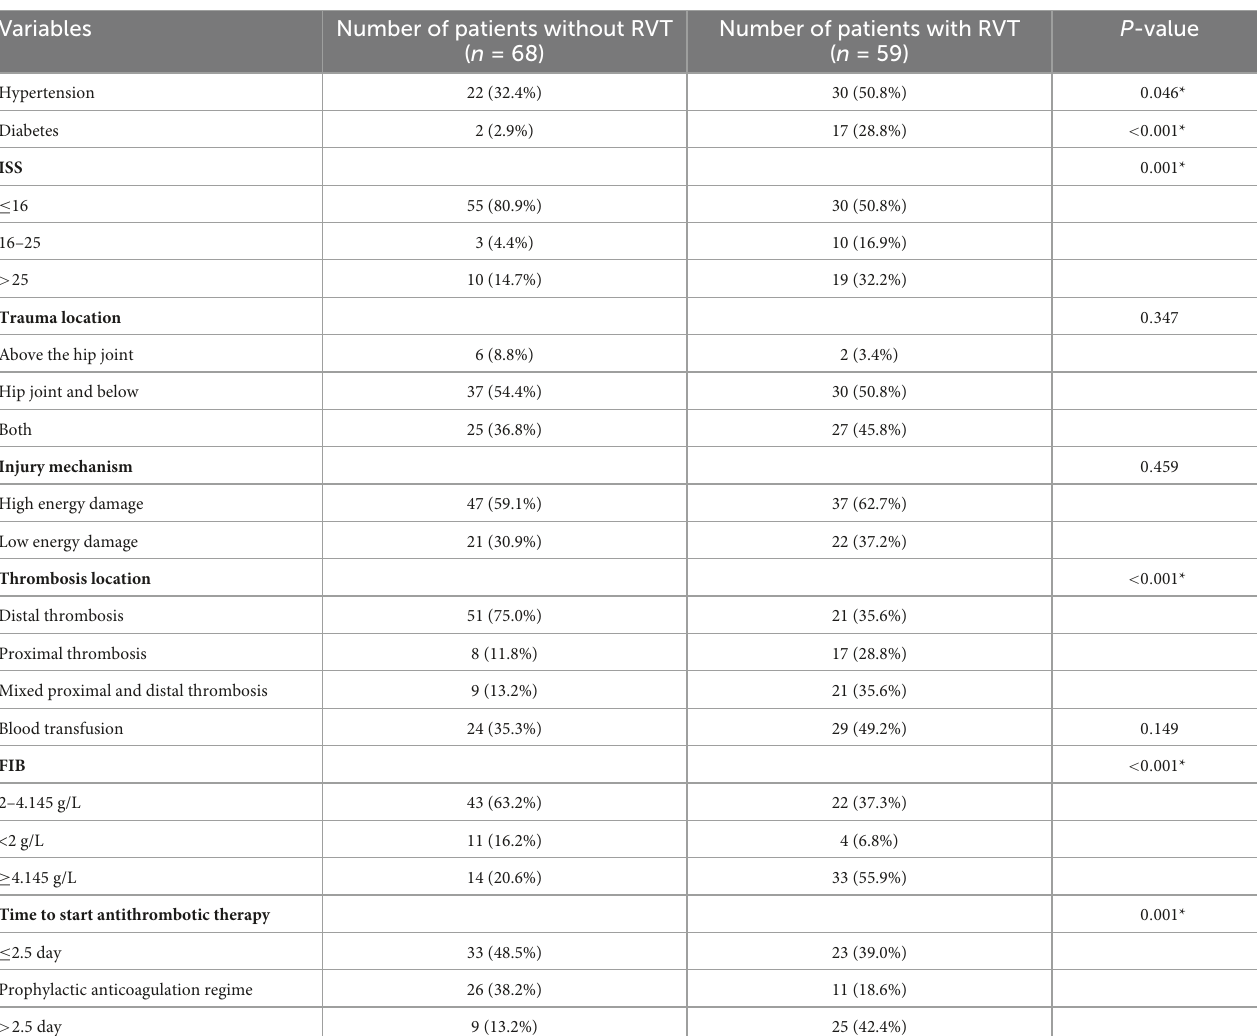
TABLE 3 Univariate analysis of categorical variables with interest.